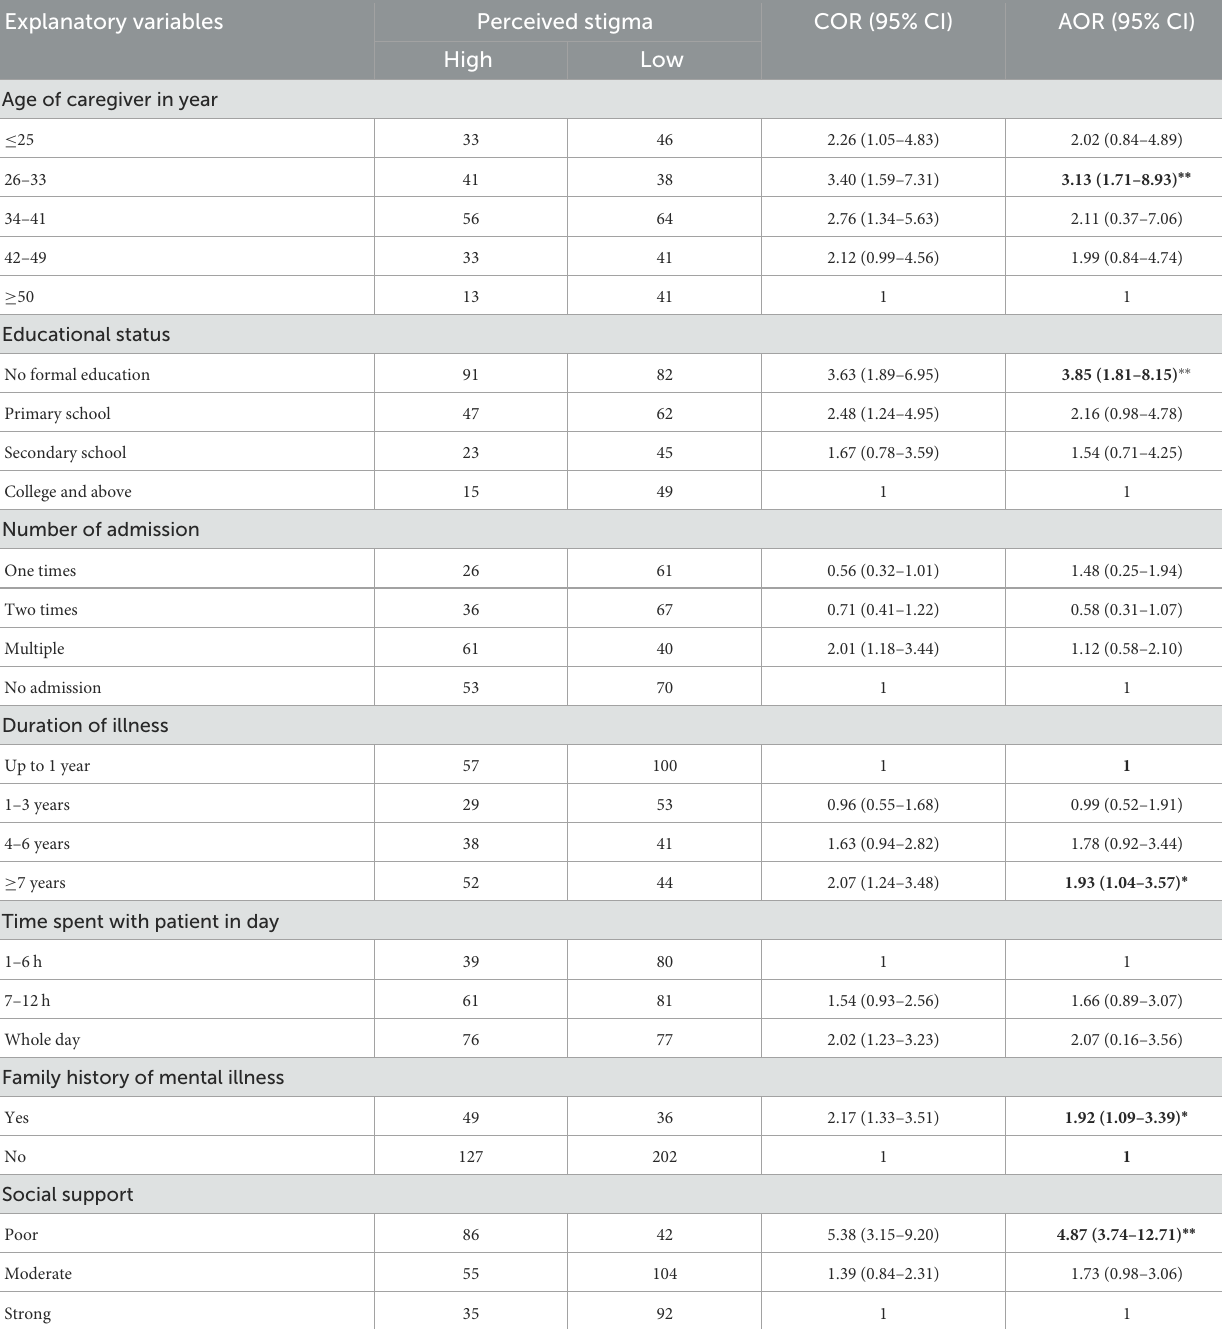
TABLE 3 Factors associated with perceived stigma in multivariate and bivariate logistic regression analysis among primary caregivers of adult patients with mental illness attending at Harari region state public hospitals, Eastern Ethiopia, 2022 ( n = 414). Explanatory variables Perceived